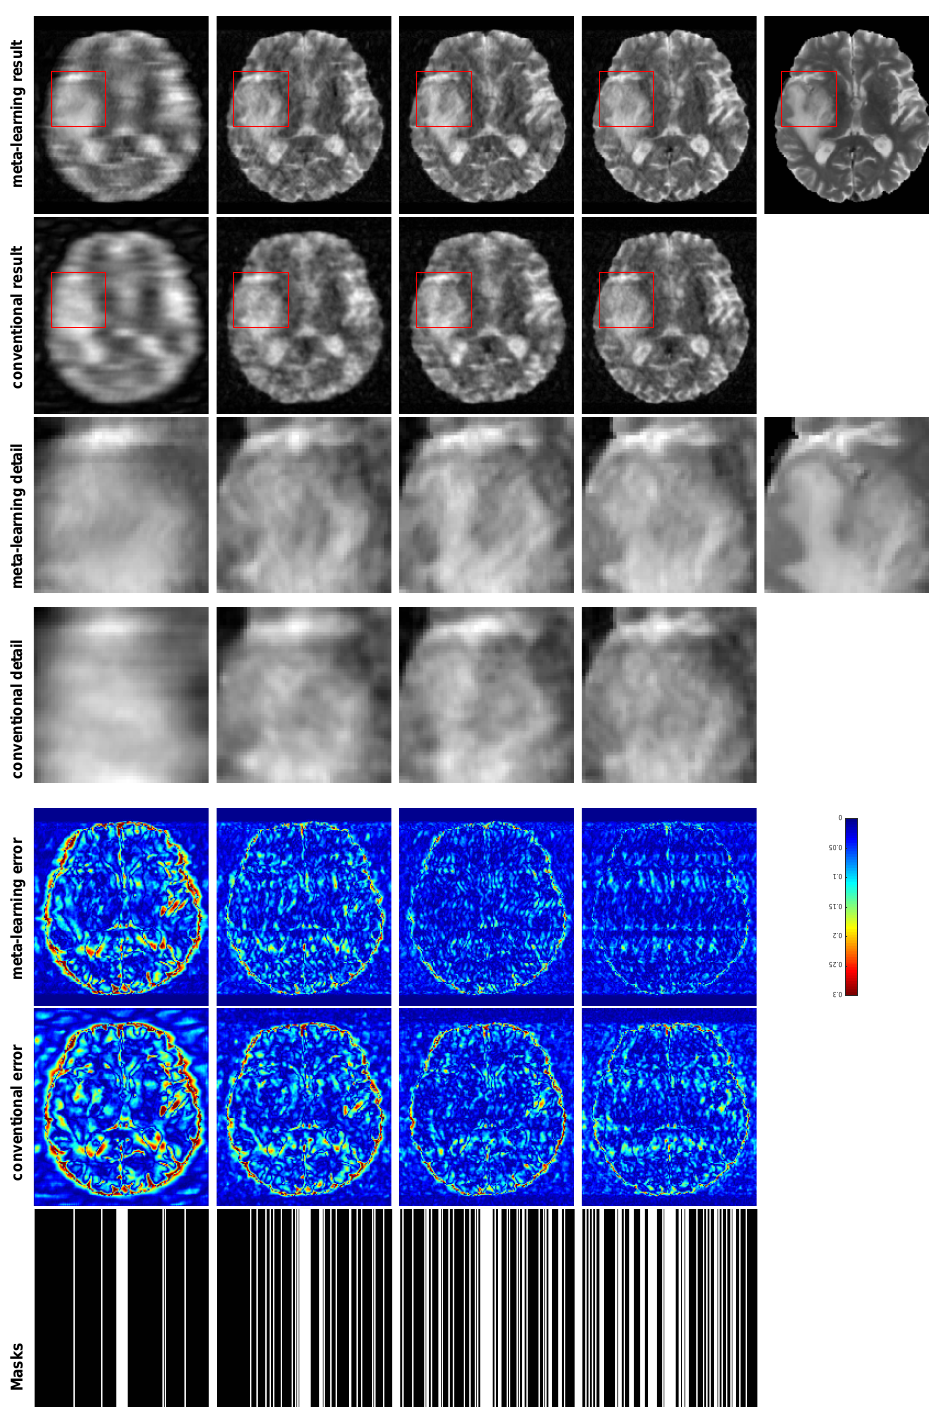
Figure 5. The pictures (from top to bottom) display the T2 brain image reconstruction results, zoomed- in details, point-wise errors with a color bar, and associated Cartesian masks for meta-learning and conventional learningwith four different CS ratios of 10%, 20%, 30%, and 40% (from left to right). The top-right image is the ground truth fully-sampled